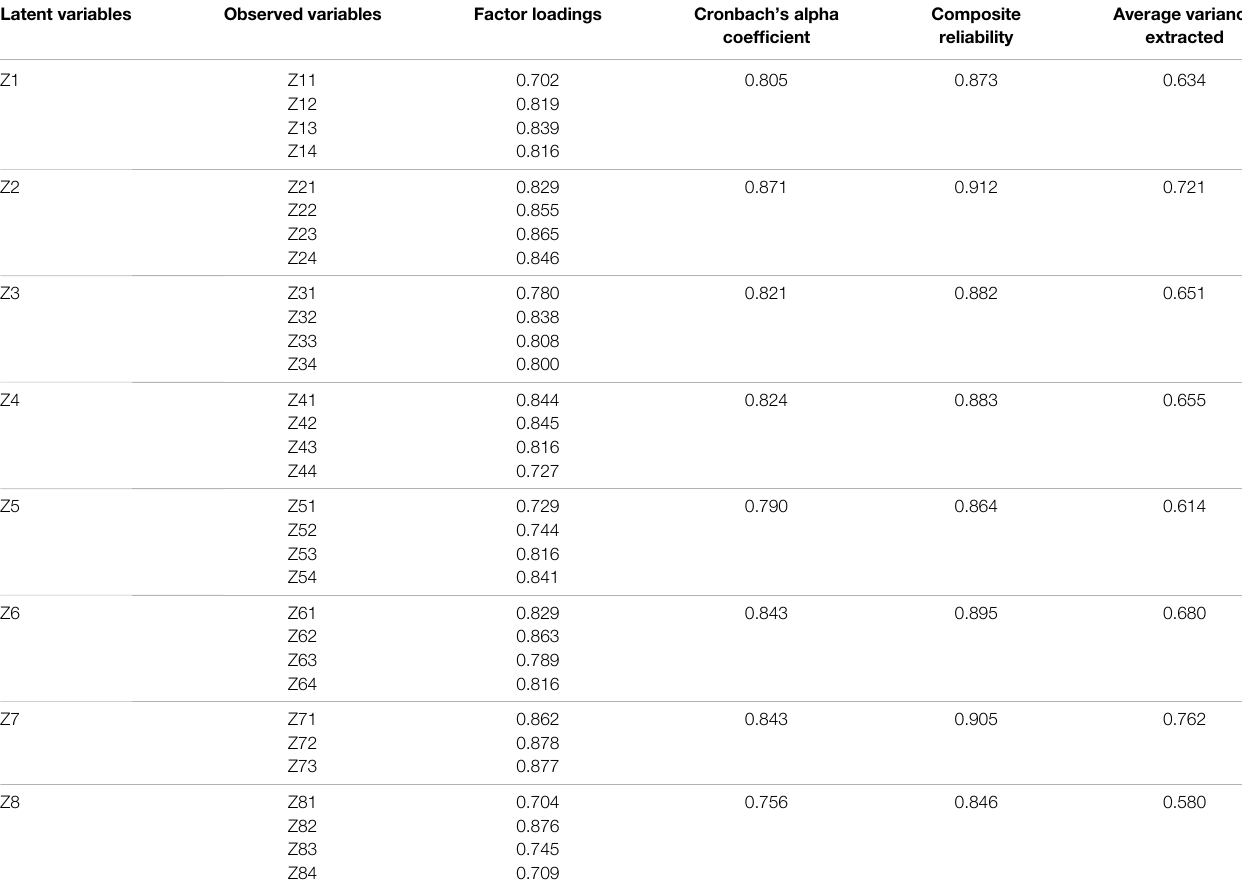
TABLE 3 | The reliability and validity test of the measurement model.